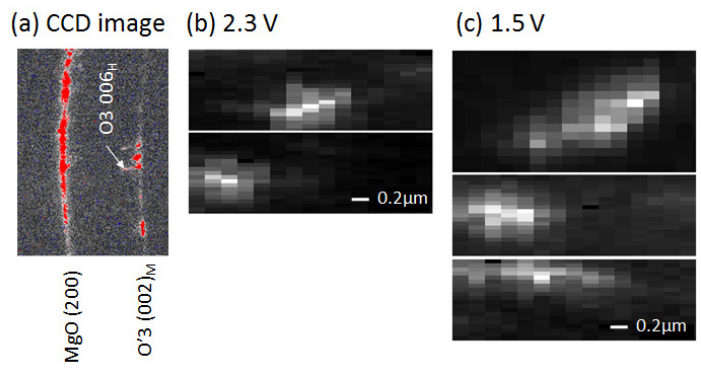
Figure 3. ( a ) Example of the charge coupled device (CCD) image of the 2.3 V film at 2 θ ∼ 33 ◦ . The footprint area of the incident X-ray was 1130 nm (H) × 260 nm (V). ( b ) X-ray microdiffraction (XRMD) images of O (cid:48) 3 domains of the 2.3 V film; and ( c ) XRMD images of O (cid:48) 3 domains of the 1.5 V